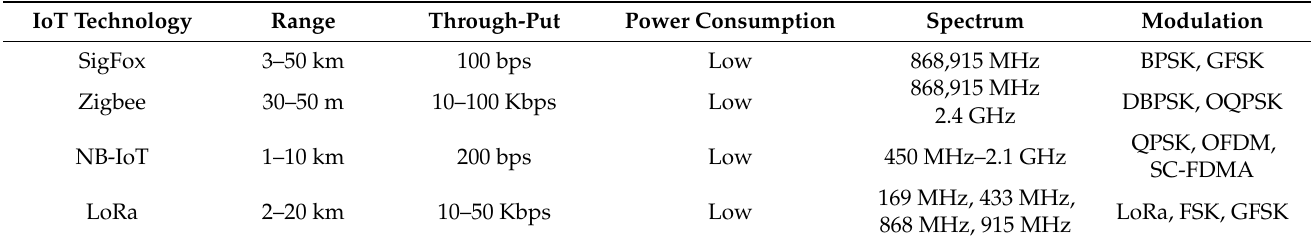
Table 2. Comparison of different IoT